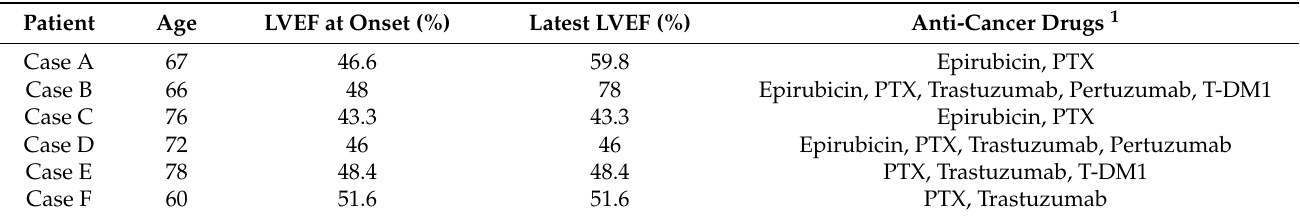
Table 2. Patients diagnosed with